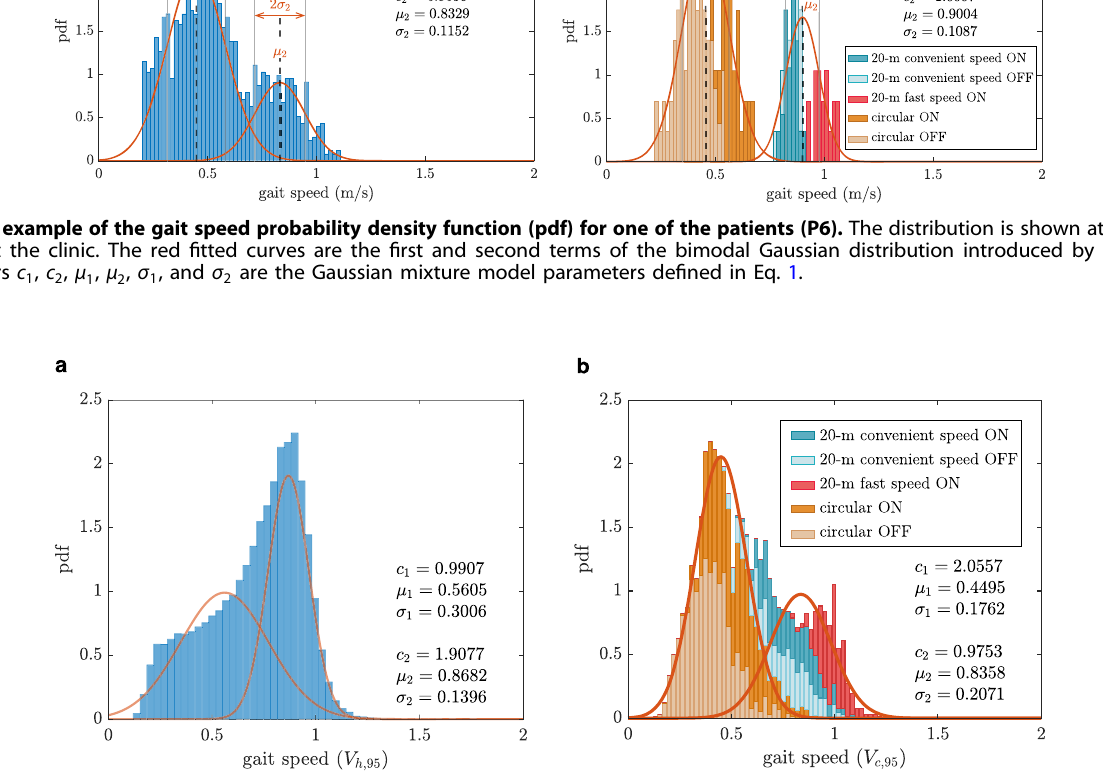
Fig. 3 The gait speed probability density function (pdf) for all the patients together. The distribution is shown at ( a ) home normalized by V h ; 95 and ( b ) the clinic normalized by V c ; 95 , the red fi tted curves are the fi rst and second terms of the bimodal Gaussian distribution introduced by Eq. 1.